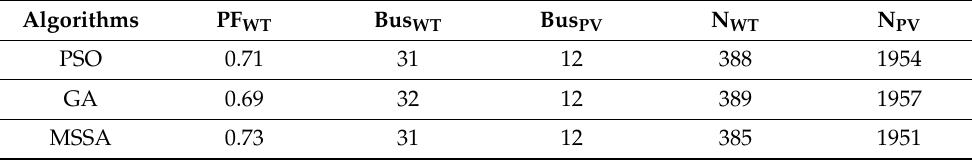
Table 5. Optimal results of the algorithms for the first scenario. Table 6. Optimal results of the algorithms for the first